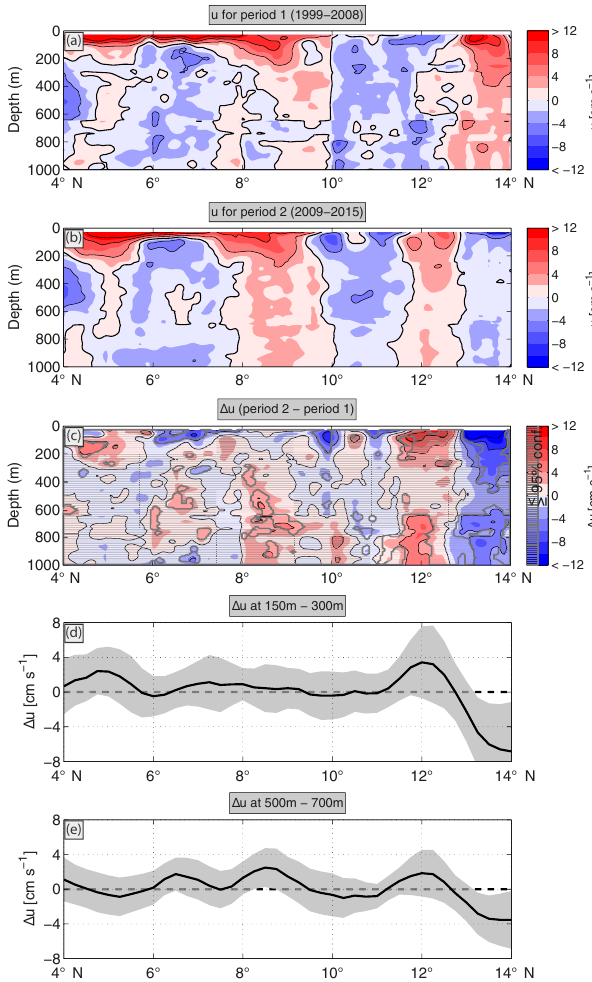
Figure 11. Depth–latitude section of mean zonal velocity from ship-